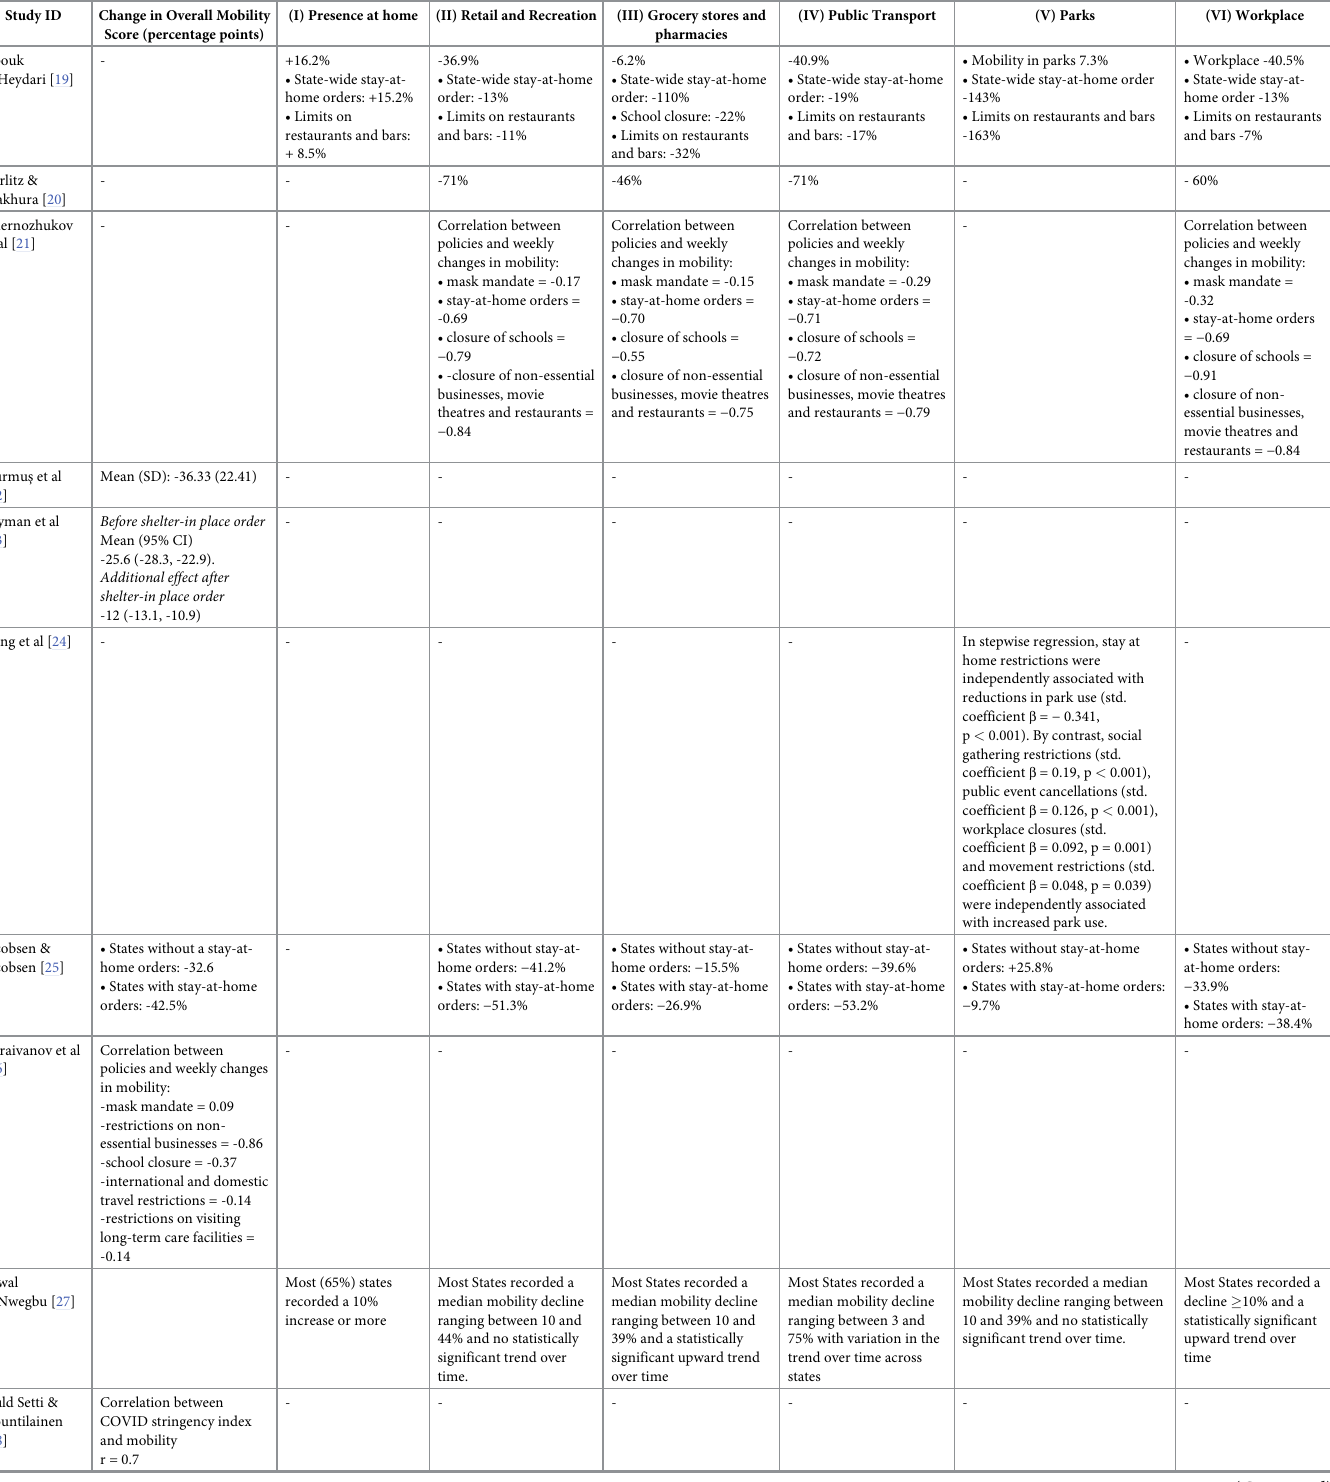
Table 3. Effects of public health restrictions of Google Mobility variables. StudyID